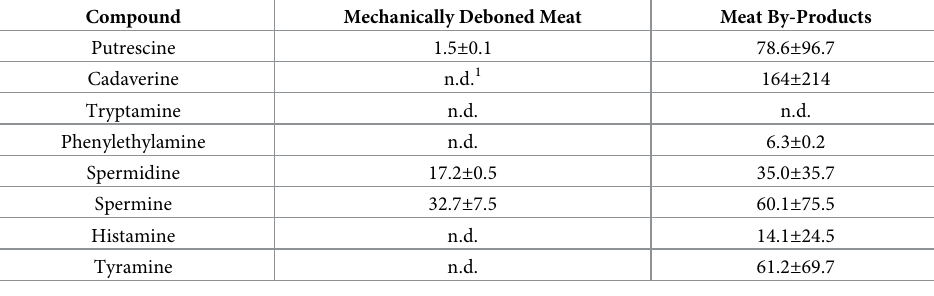
Table 8. Natural polyamines (mean ± SD, mg/kg, as-fed basis) of the two types of meat (fresh and meal). Compound